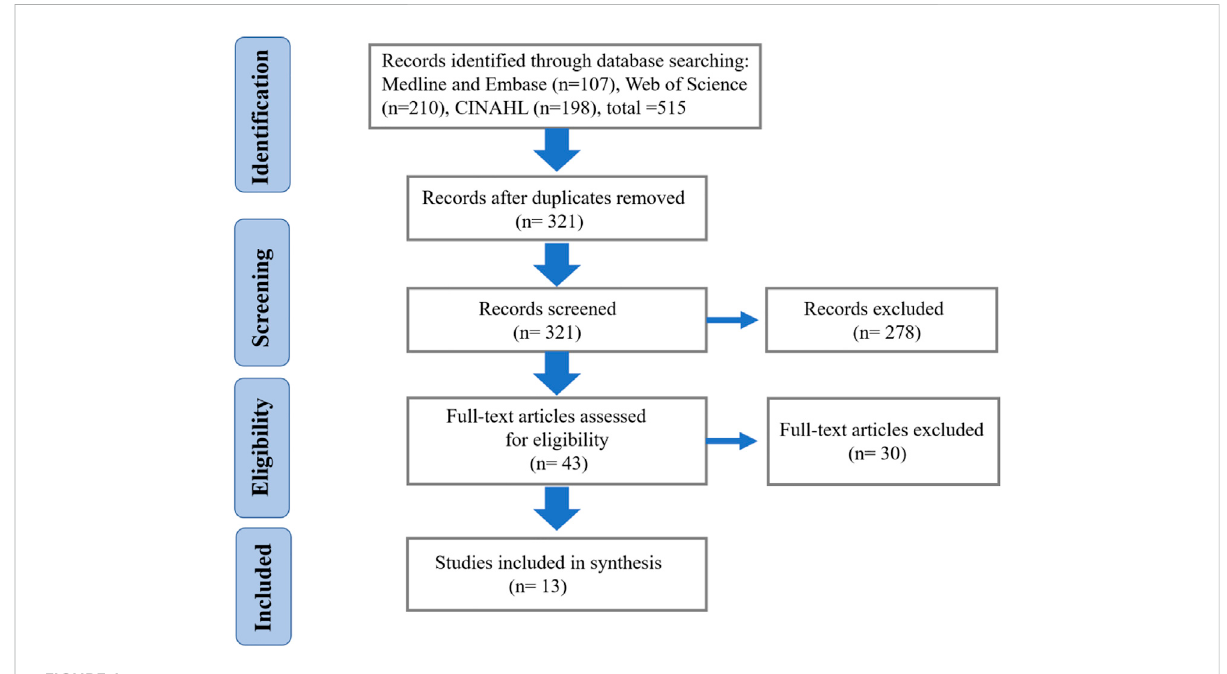
FIGURE 1 The process of article